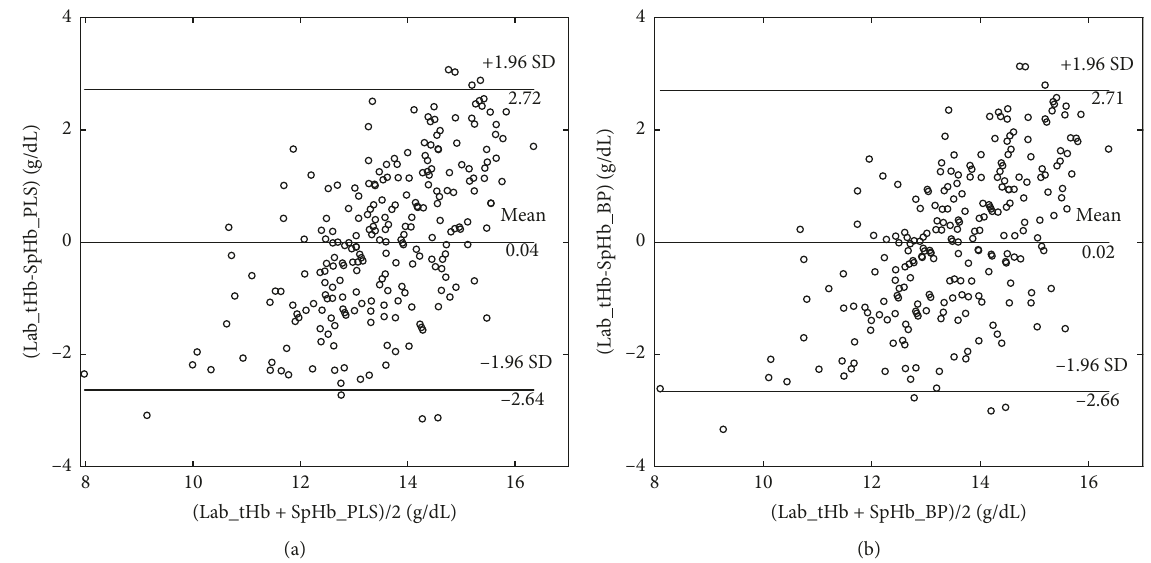
Figure 5: Bland–Altman plot for the Hb values. (a) Differences and mean of the Lab_tHb and SpHb_PLS and (b) differences and mean of the Lab_tHb and